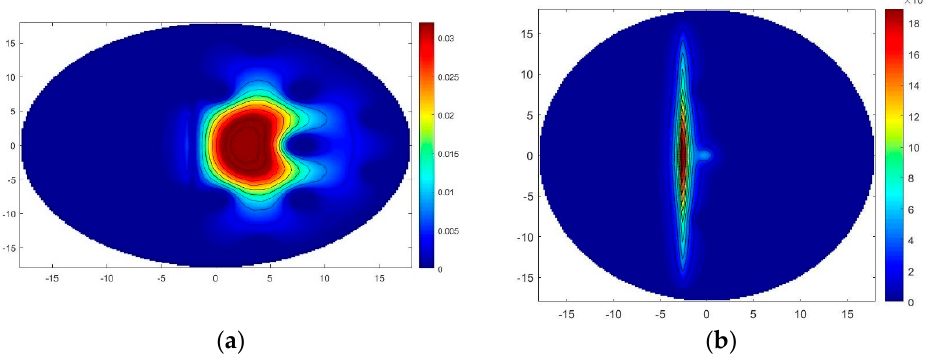
Figure 3. Magnetic field in fiber for: ( a ) Fiber with SiO 2 defect, n a = 1.43 and λ = 1.55 µ m; ( b ) Defect with doping SiO 2 + GeO 2 ( 13.5% ) , n a = 1.43 and λ = 1.55 µ m .